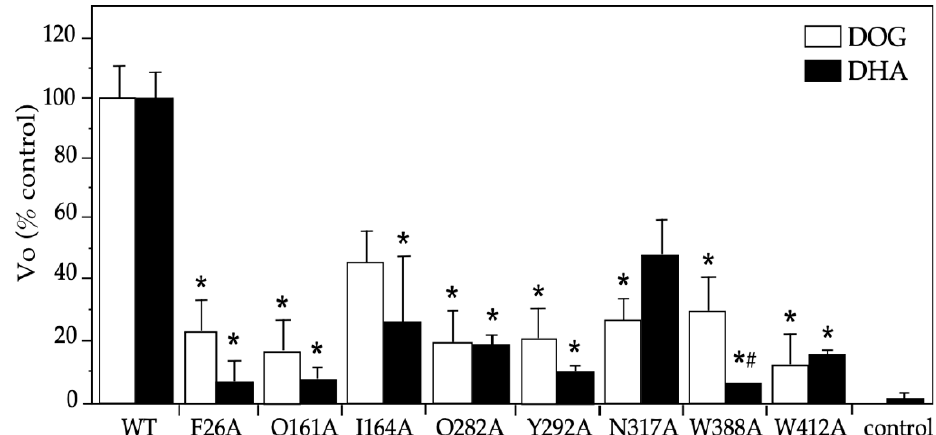
Figure 4. Initial rates for DOG and DHA transport mediated by GLUT1 mutants in Xenopus laevis oocytes. Uptake was carried out at 2 min intervals using DOG (0.5 mM) and DHA (0.1 mM), and the slopes of the time-curse plots were graphed. The maximum transport time was 10 min for DOG and 15 min for DHA. The X. laevis oocytes were injected with 40 ng of hGLUT1 cRNA or its mutants or if in the control, an equal volume of water. Three experiments were carried out in triplicates, counting four oocytes per sample. The data are expressed as mean ± SD with respect to the WT (6.30 ± 0.68 pmoles/oocyte × min for DOG and 6.30 ± 0.60 pmoles/oocyte × min). DHA: dehydroascorbic acid, DOG: 2-deoxyglucose, WT: wildtype GLUT1, Vo: initial rate. * p > 0.01 with respect to the